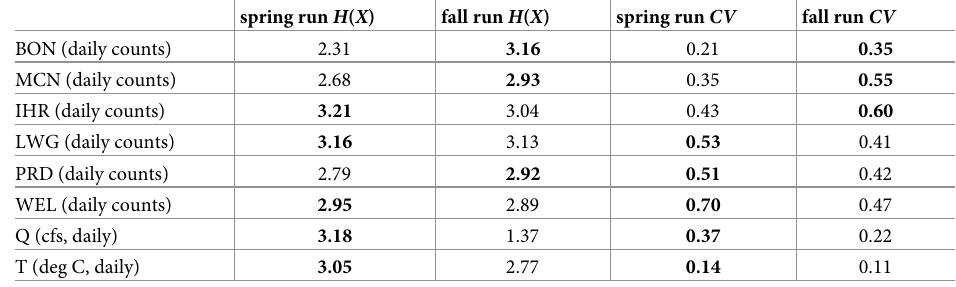
Table 2. Entropy ( H ( X )) in units of bits for fall and spring runs for daily salmon counts at six dams (listed by site name) and flow rate ( Q ) and water temperature ( T ) in the Lower Columbia River, along with the coefficient of var- iation ( CV ) for comparison. The largest value of the two time windows is highlighted in bold for each category. spring run H ( X